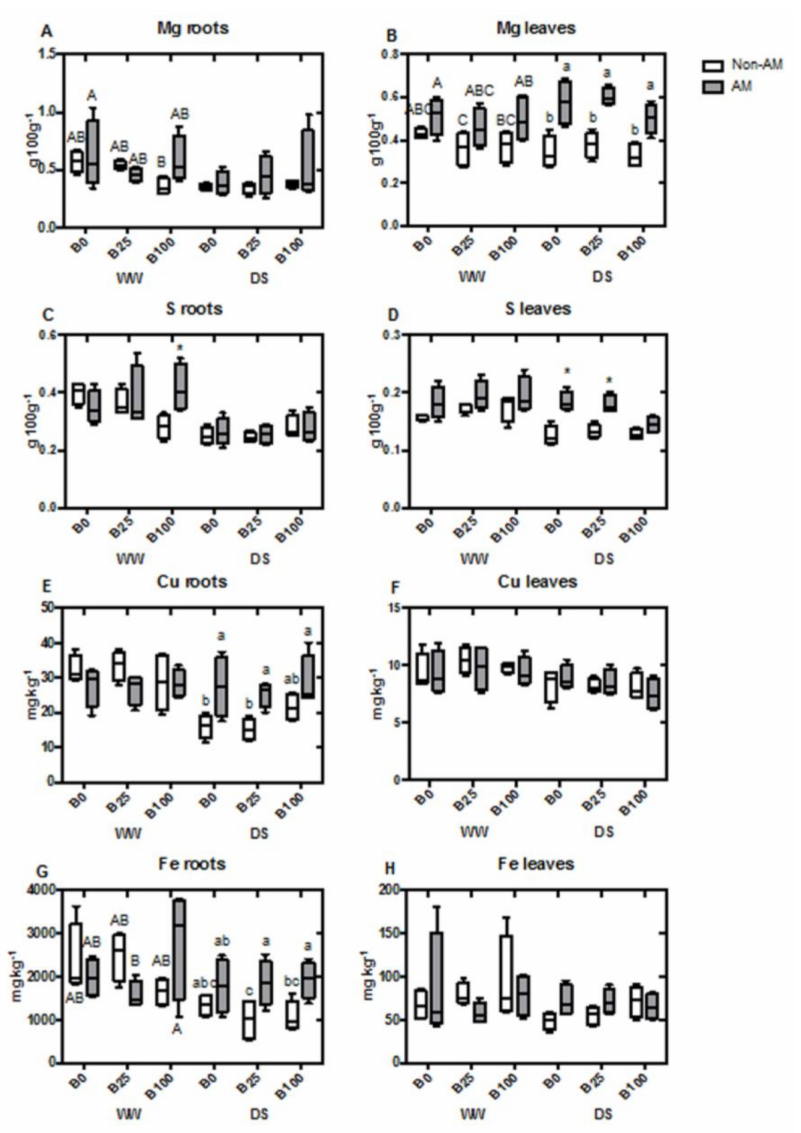
Figure 2. Boxplots representing root and leaf concentrations of Mg in roots ( A ) and in leaves ( B ), S in roots ( C ) and in leaves ( D ), Cu in roots ( E ) and in leaves ( F )and Fe in roots ( G ) and in leaves ( H ). Boxes represent the interquartile range, with the line representing the median, whiskers represent maxima and minima within 1.5 times the interquartile range. Di ff erent letters indicate significant di ff erences among treatments ( p < 0.05) based on Duncan’s test. Asterisks indicate significant di ff erences between non-AM and AM plants within each treatment, according to t